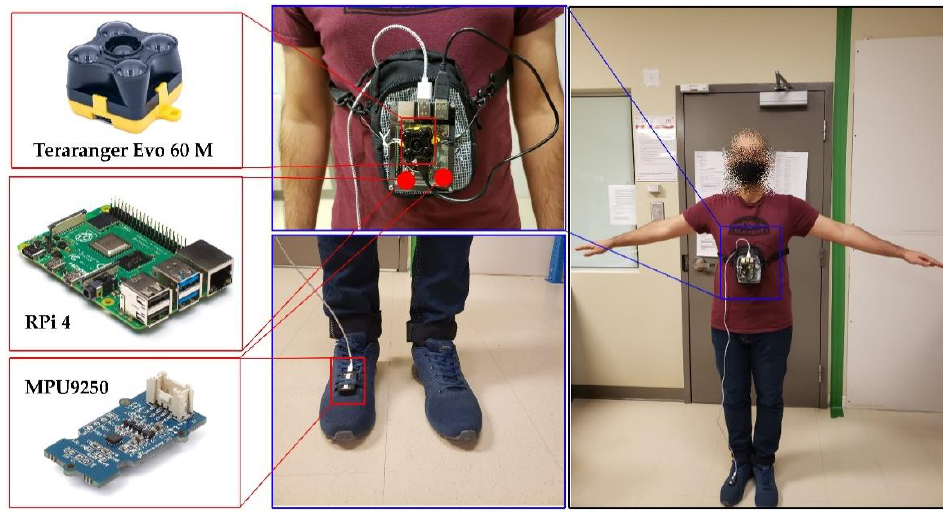
Figure 8. Experimental hardware and software setup.